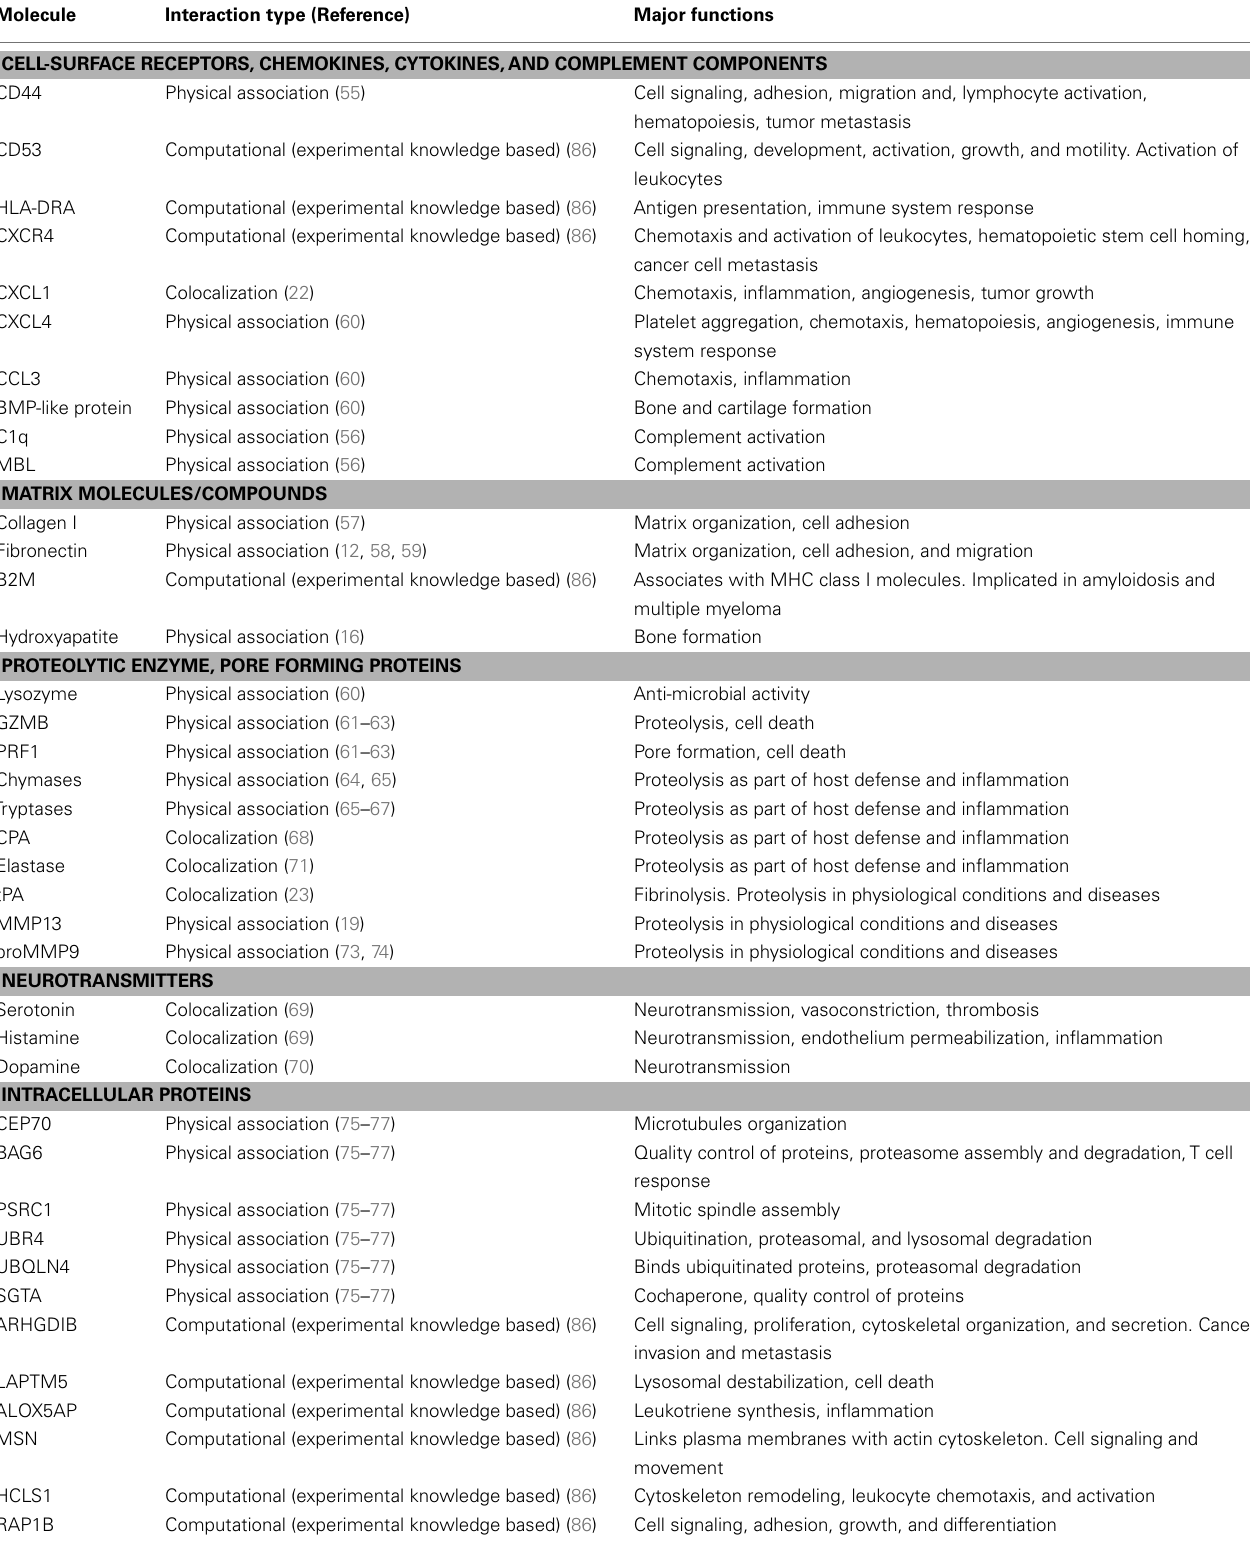
Table 1 | Overview of serglycin binding partners